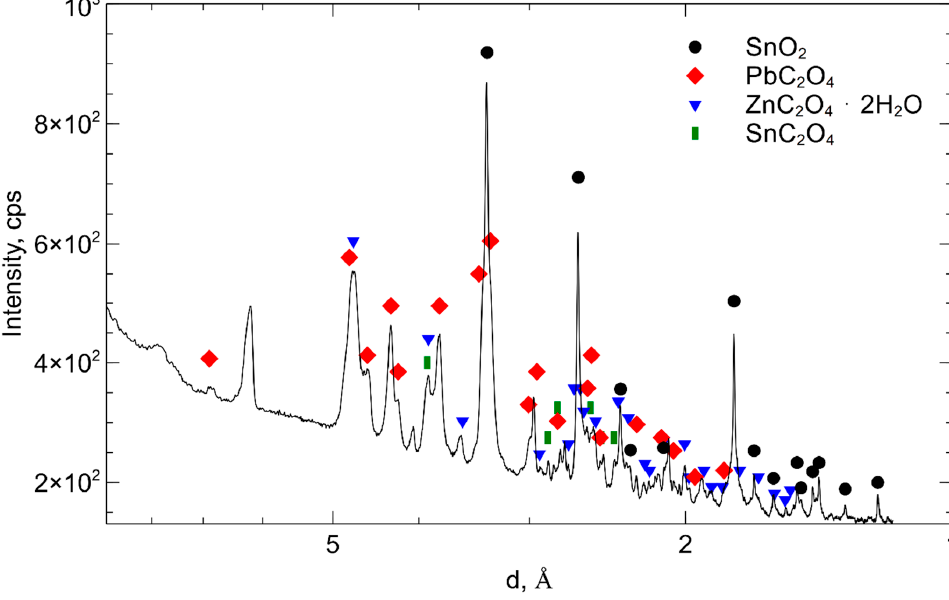
Figure 6. X-ray powder diffraction (XRD) pattern of the residue obtained after leaching of GeIn dross in oxalic acid solution.